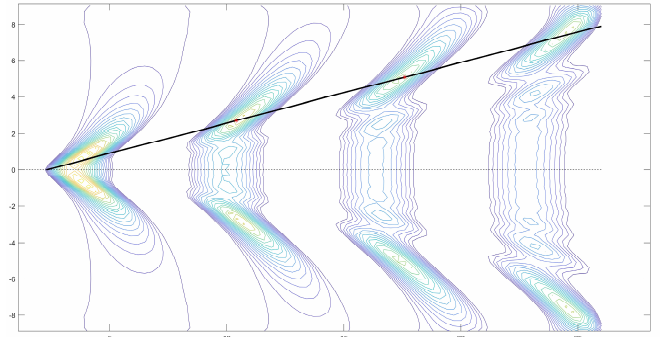
Figure 7. A contour plot of the nonlinear free surface profile for flow past the Rankine source with the Froude number 𝐹′ = 1.0 and the source strength 𝜇 (cid:4593) = 1.0, computed on a 181 × 61 mesh with ∆𝑥′ = 0.3,∆𝑦′ = 0.3 .